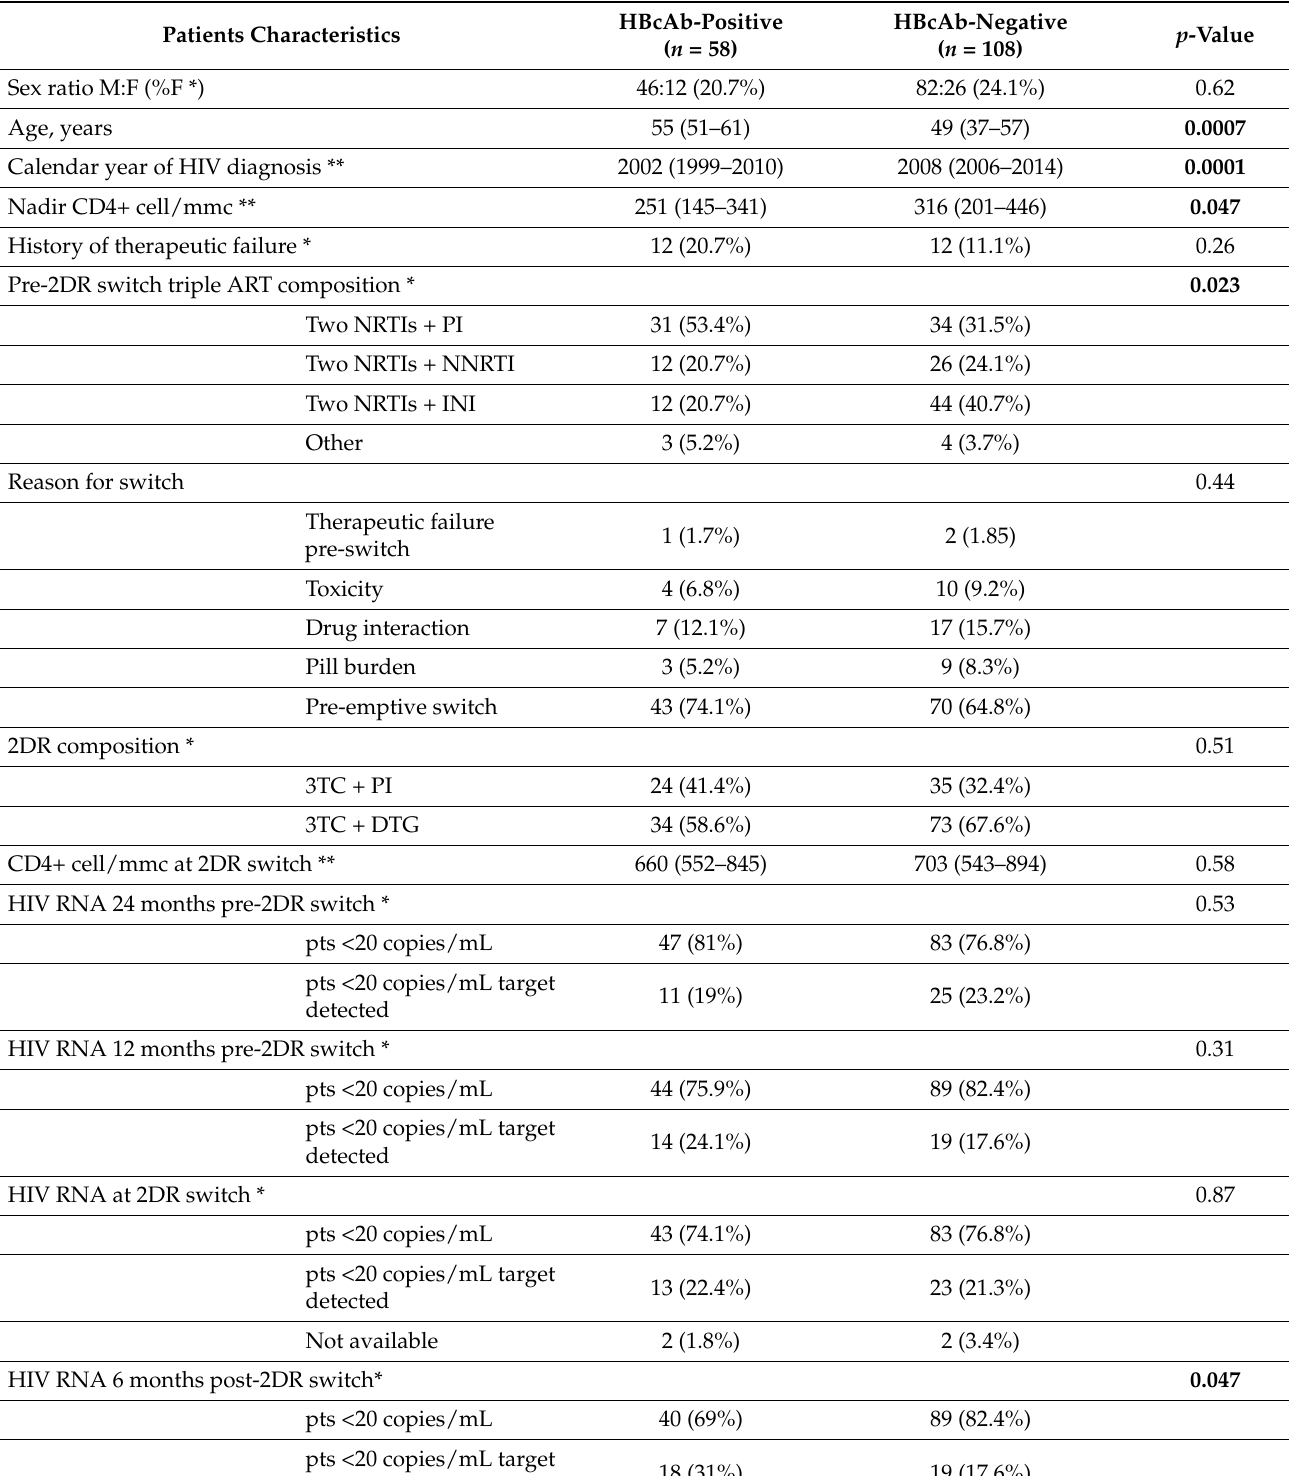
Table 2. Comparison of HIV viral load values at the different time points between the HBcAb-positive patients living with HIV (PLWH) and HBcAb-negative PLWH